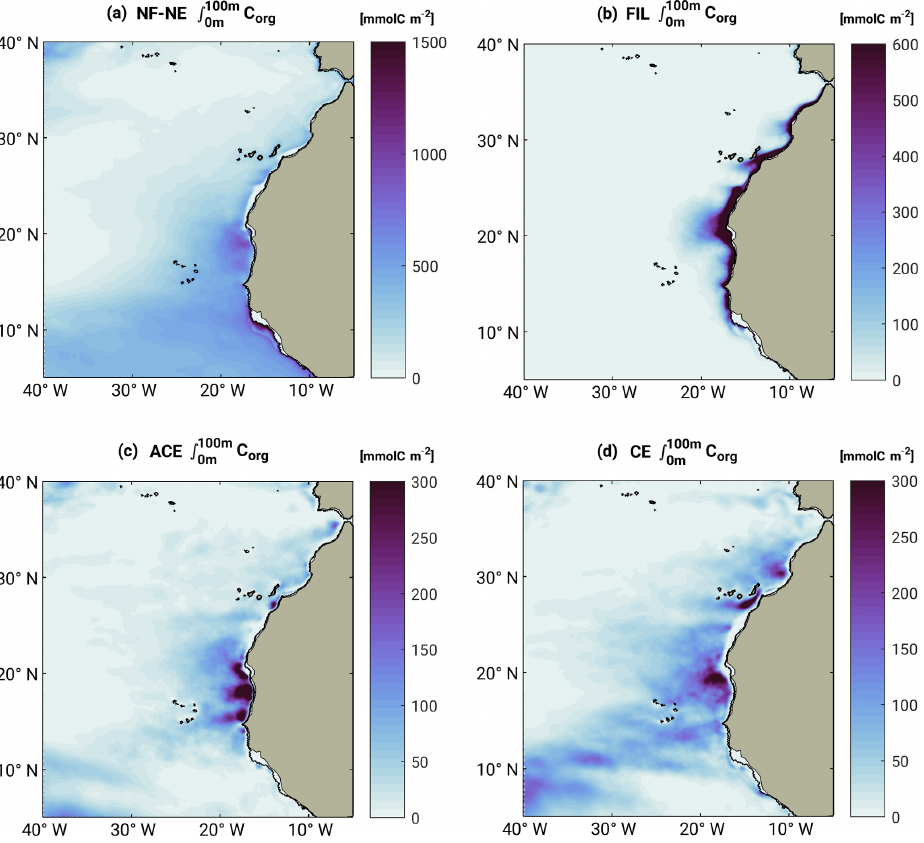
Figure B9. Spatial distribution of the 100m vertically integrated C org [mmolCm − 2 ] in (a) non-filament-non-eddy (NF-NE) field, (b) fila- ments (FIL), (c) anticyclones (ACE), (d) cyclones